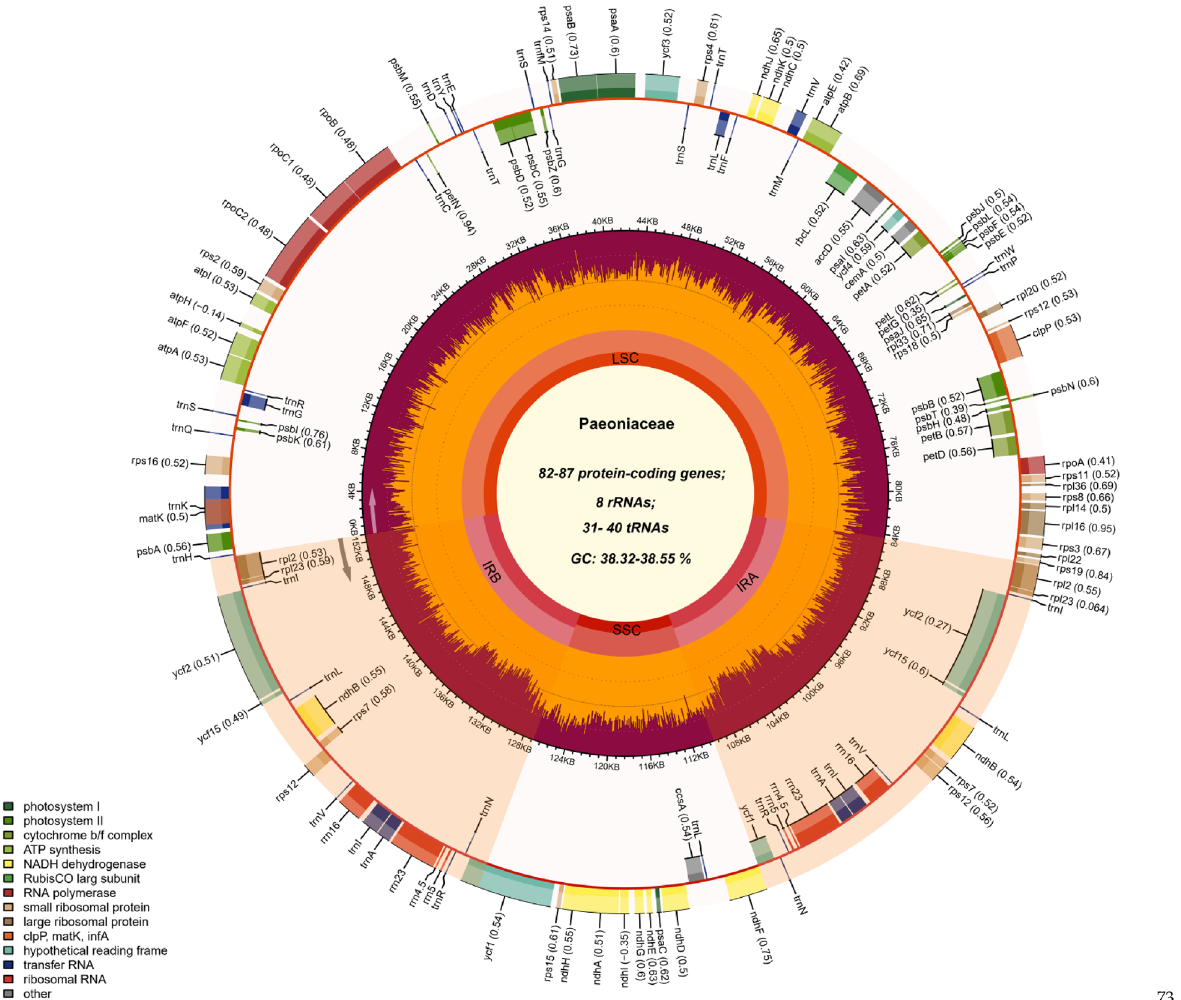
Figure 1. Chloroplast genome map of Paeoniaceae species, using P. intermedia as the template. The gradient GC content of the genome was plotted in the second circle with zero level based on the outer circle. The gene names and their codon usage bias were labeled on the outermost layer. The gene specific GC content was depicted with the proportion of shaded areas. Represented with arrows, the transcription directions for the inner and outer genes were listed clockwise and anticlockwise,